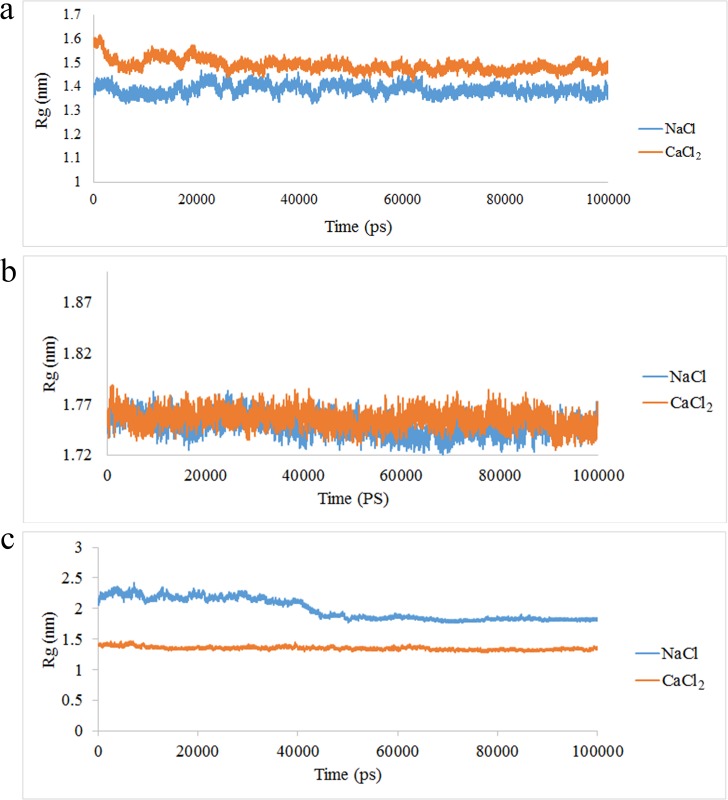
The Rg value of (a) A9, (b) A8 and (c) A8/A9 protein in presence of Na+ and Ca2+.